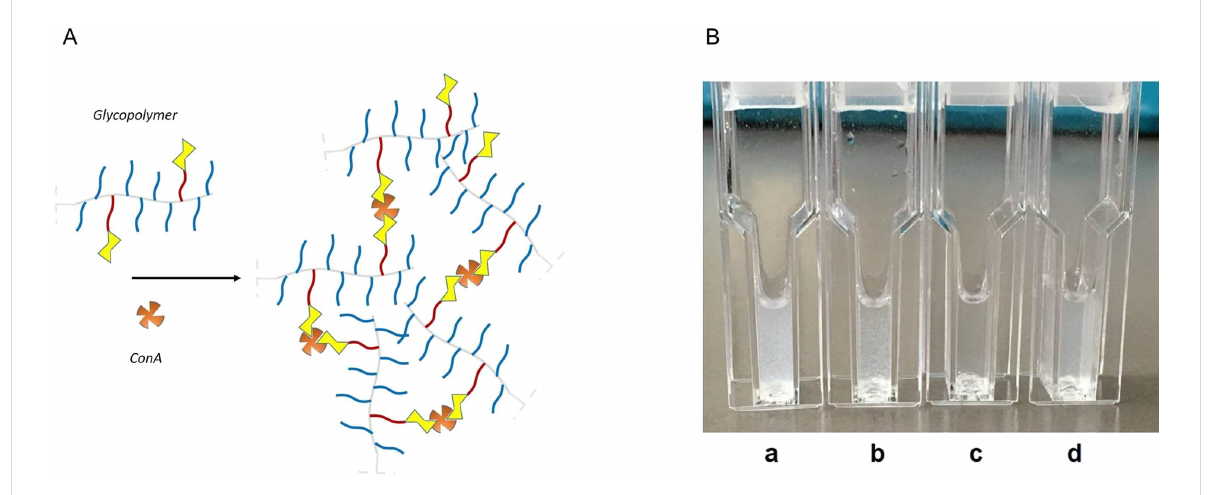
Figure 6: A) Schematic representation of Con A clustering by multivalent ligands. B) Con A suspensions after interaction with (a) PEG 8 -PCL 2 -Man 2 (turbid), (b) A4-PEG 8 -PCL 2 -Man 2 (turbid), (c) PEG 9 -PCL 1 -Man 1 (transparent) and (d) A4-PEG 9 -PCL 1 -Man 1 (turbid).